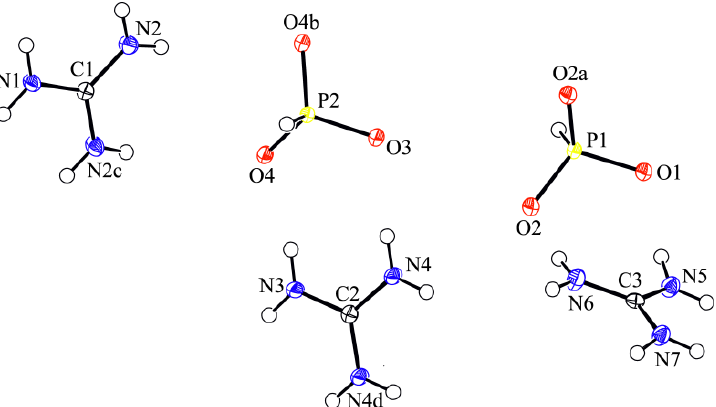
Figure 3. Atom numbering of bis(guanidinium) phosphite—compound ( V ). The anisotropic displacement parameters are shown at the 50% probability level. The symmetry codes for the atoms O2a and O4b: x , − y , z ; for the atoms N2c and N4d: x , 1 − y , z . Applied colours: C—black, N—blue, O—red, H—black contour, P—yellow. The Figure was prepared by [17].